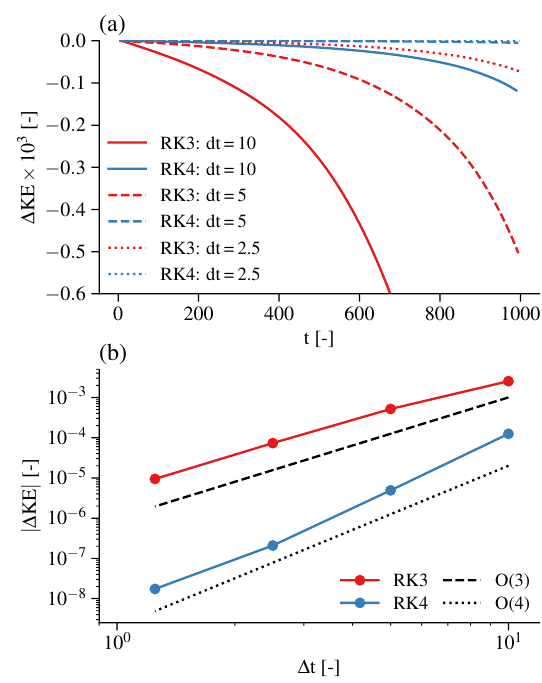
Figure 3. Time evolution of the kinetic energy change (cid:49) KE during 1000 time units of random noise advection for the RK3 and RK4 time integration schemes with three different time steps (a) .